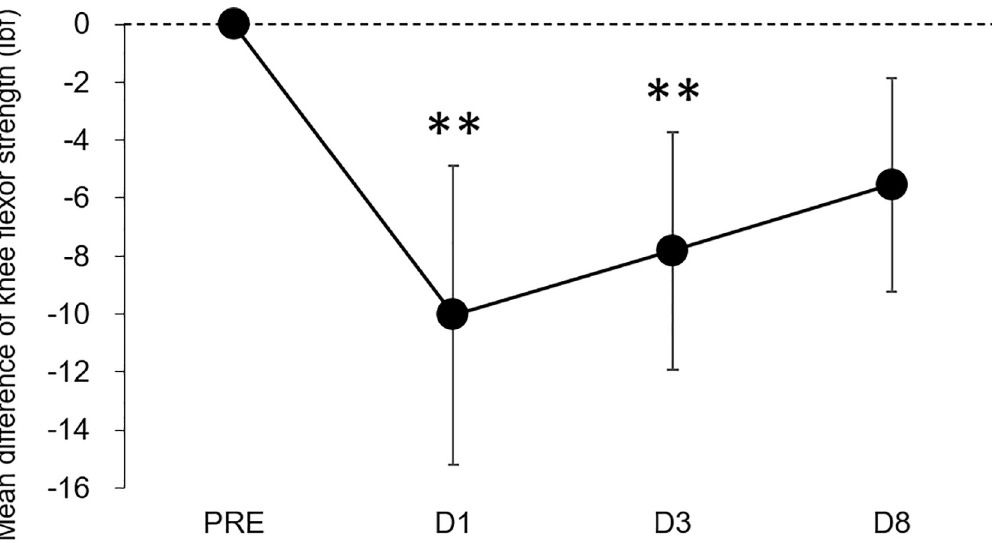
Fig 4. Mean difference in maximal isometric knee flexion torque from the baseline (PRE). Error bars indicate 95% confidence intervals. D1, 1 day after marathon; D3, 3 days after marathon; D8, 8 days after marathon.